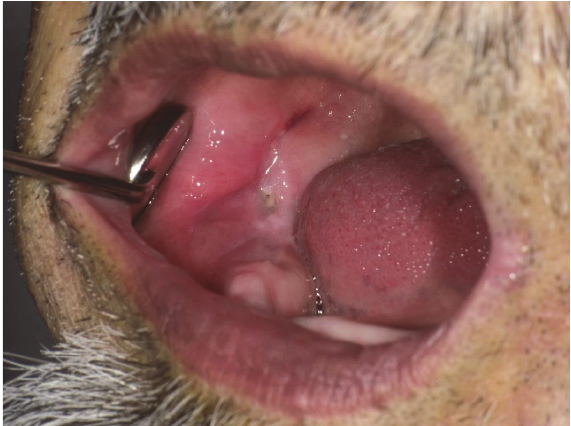
Figure 2: An inner tooth fistula could be observed in the lower right corner. The fistula exuded pus from the impacted wisdom tooth.